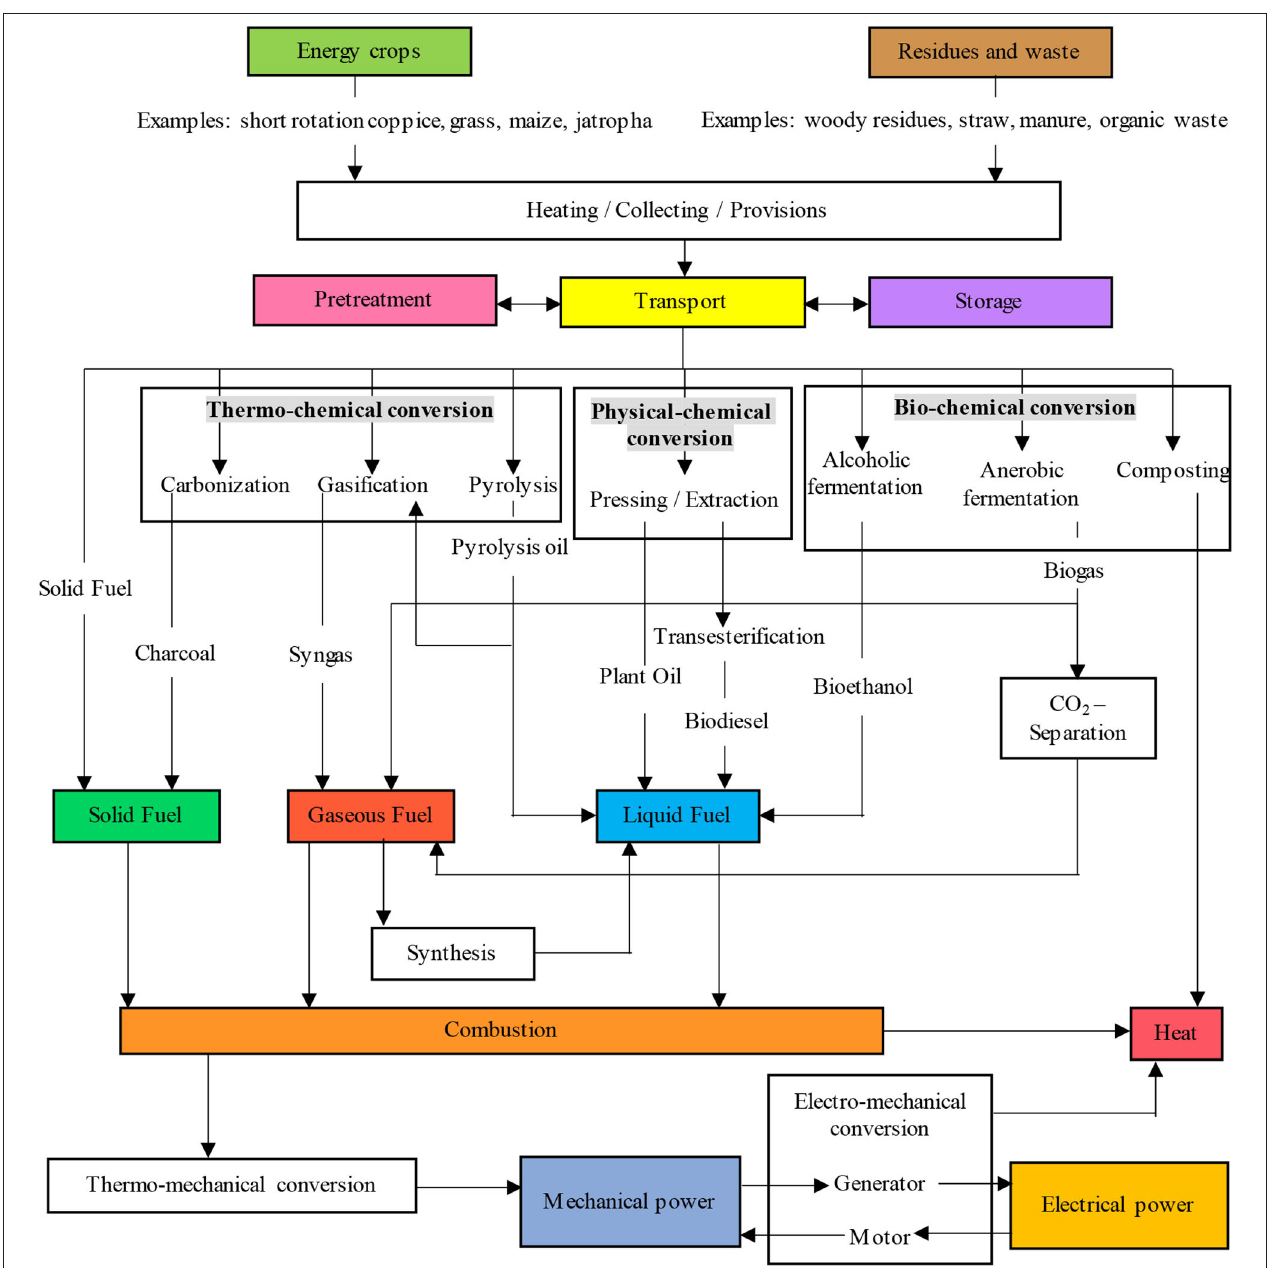
FIGURE 4 | Simplified description of bioenergy pathways (adapted from Sterner, 2009; with permission from the